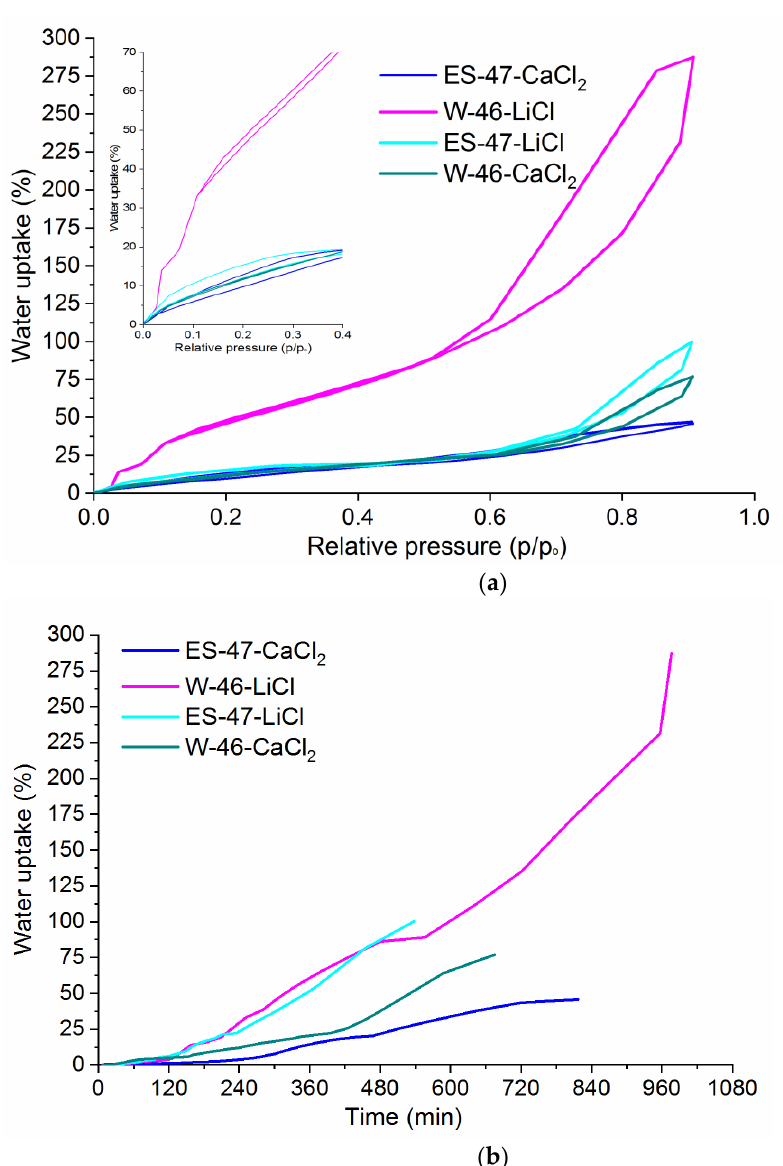
Figure 6. ( a ) Water uptake curves and ( b ) water sorption kinetics curves of the composites with W-46 and ES-47 supports at 35 °C.